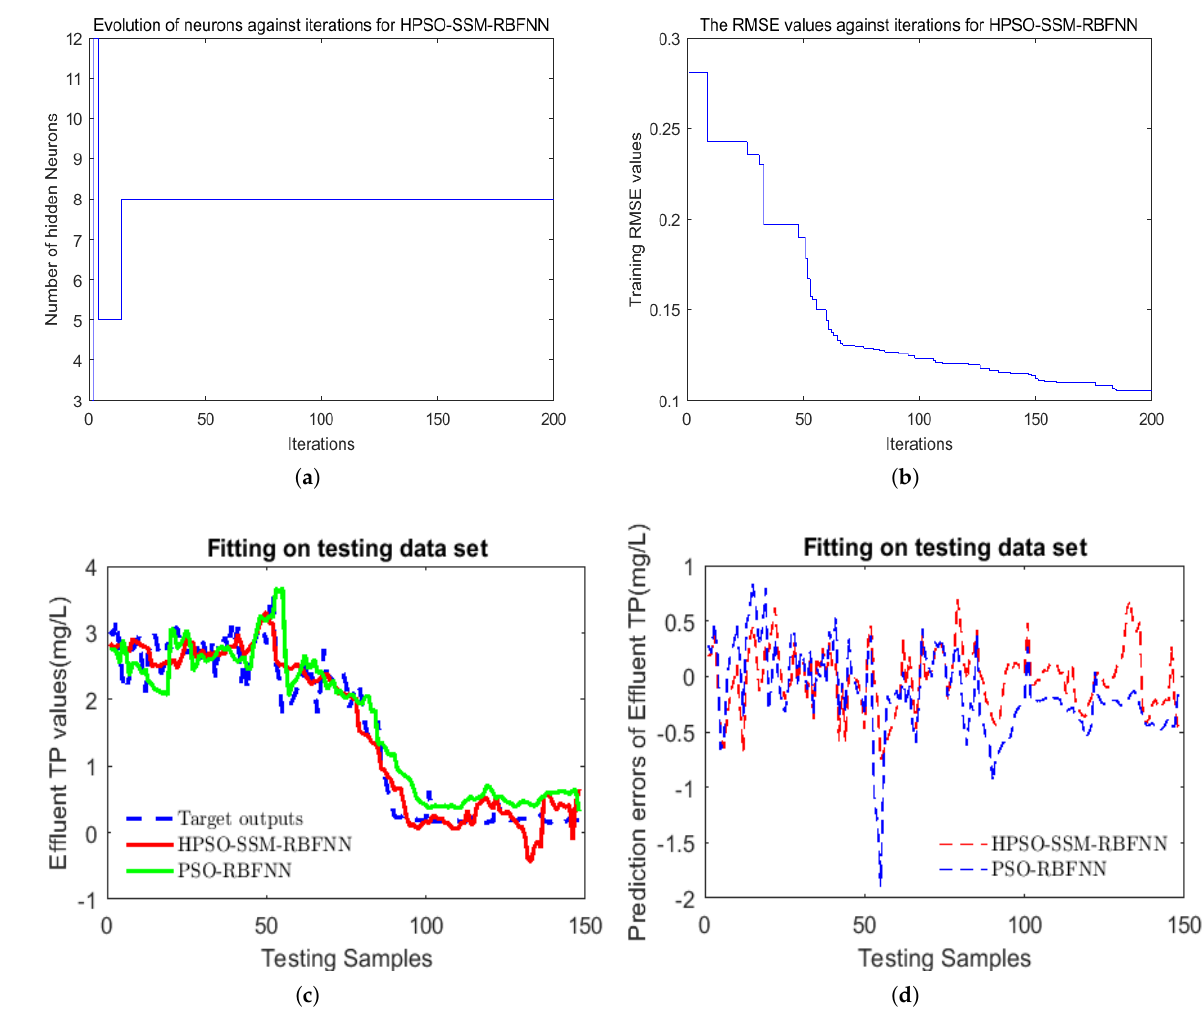
Figure 5. The presented approach’s efficacy is measured in terms of ( a ) neurons buried during training, ( b ) the RMSE values in the training phase, ( c ) prediction results during the testing phase, ( d ) the proposed HPSO-SSM-RBFNN for total phosphorus (TP) prediction in